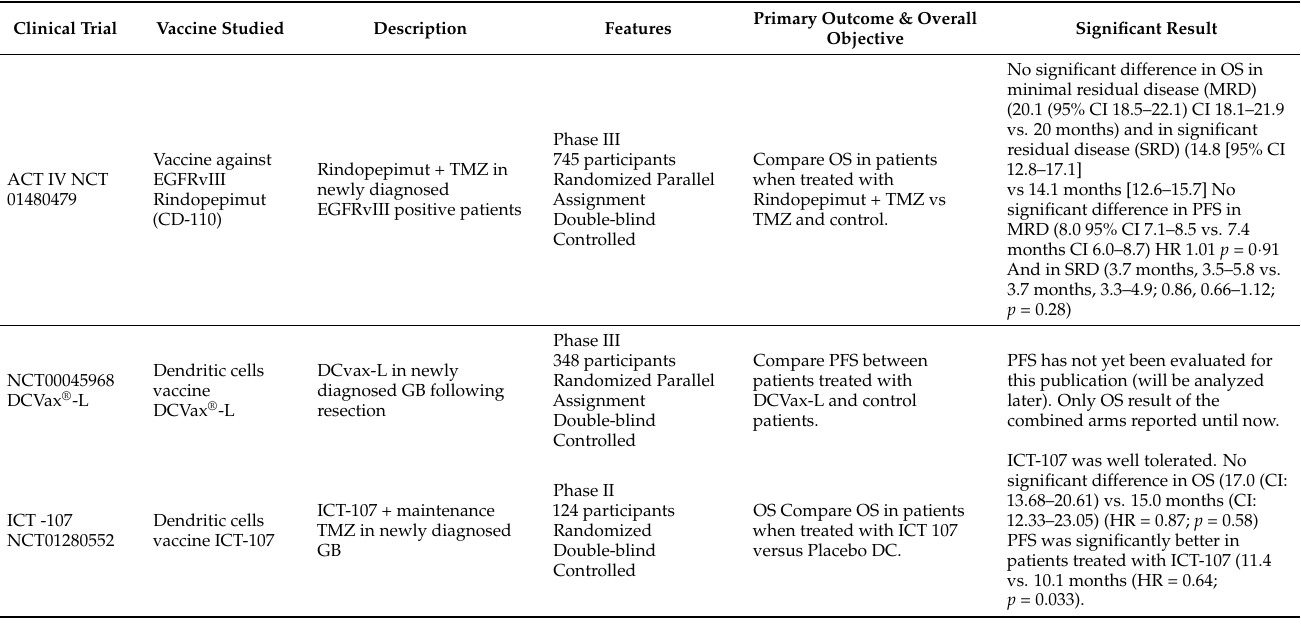
Table 1. Vaccine